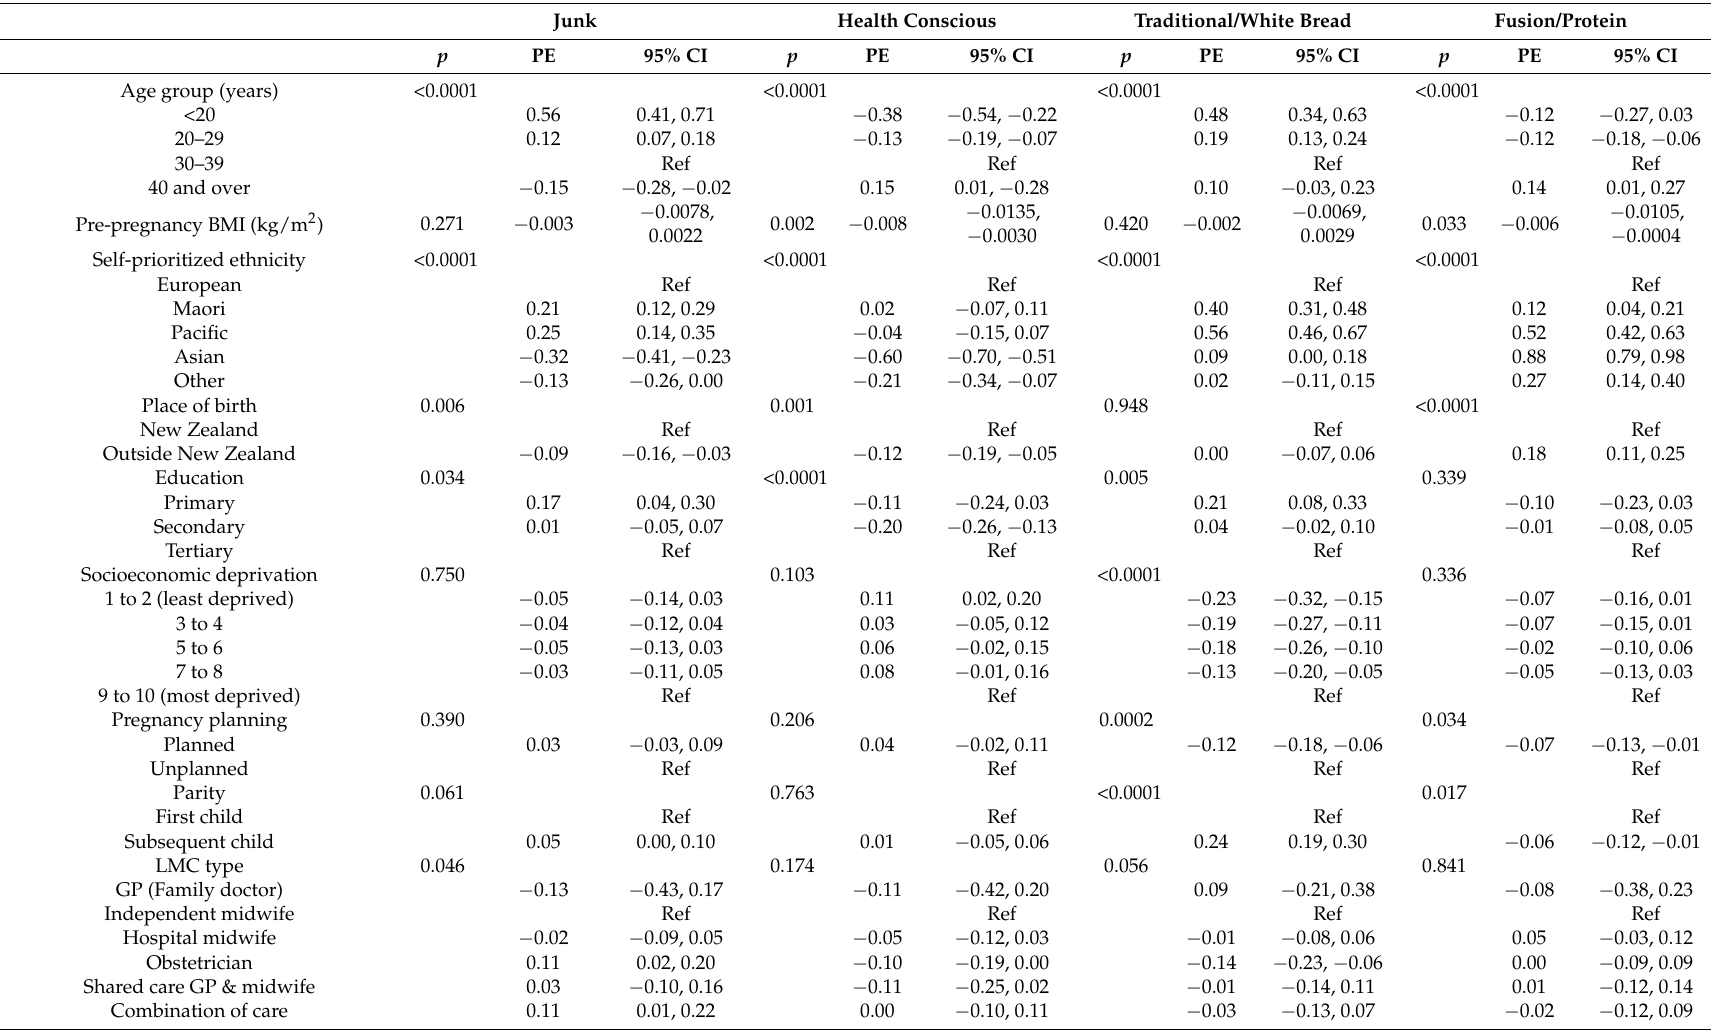
Table 2. Association of each maternal dietary pattern with various maternal socio-demographic, health and lifestyle factors, adjusting for all other factors in the table (Parameter estimates (PE) and 95% confidence intervals